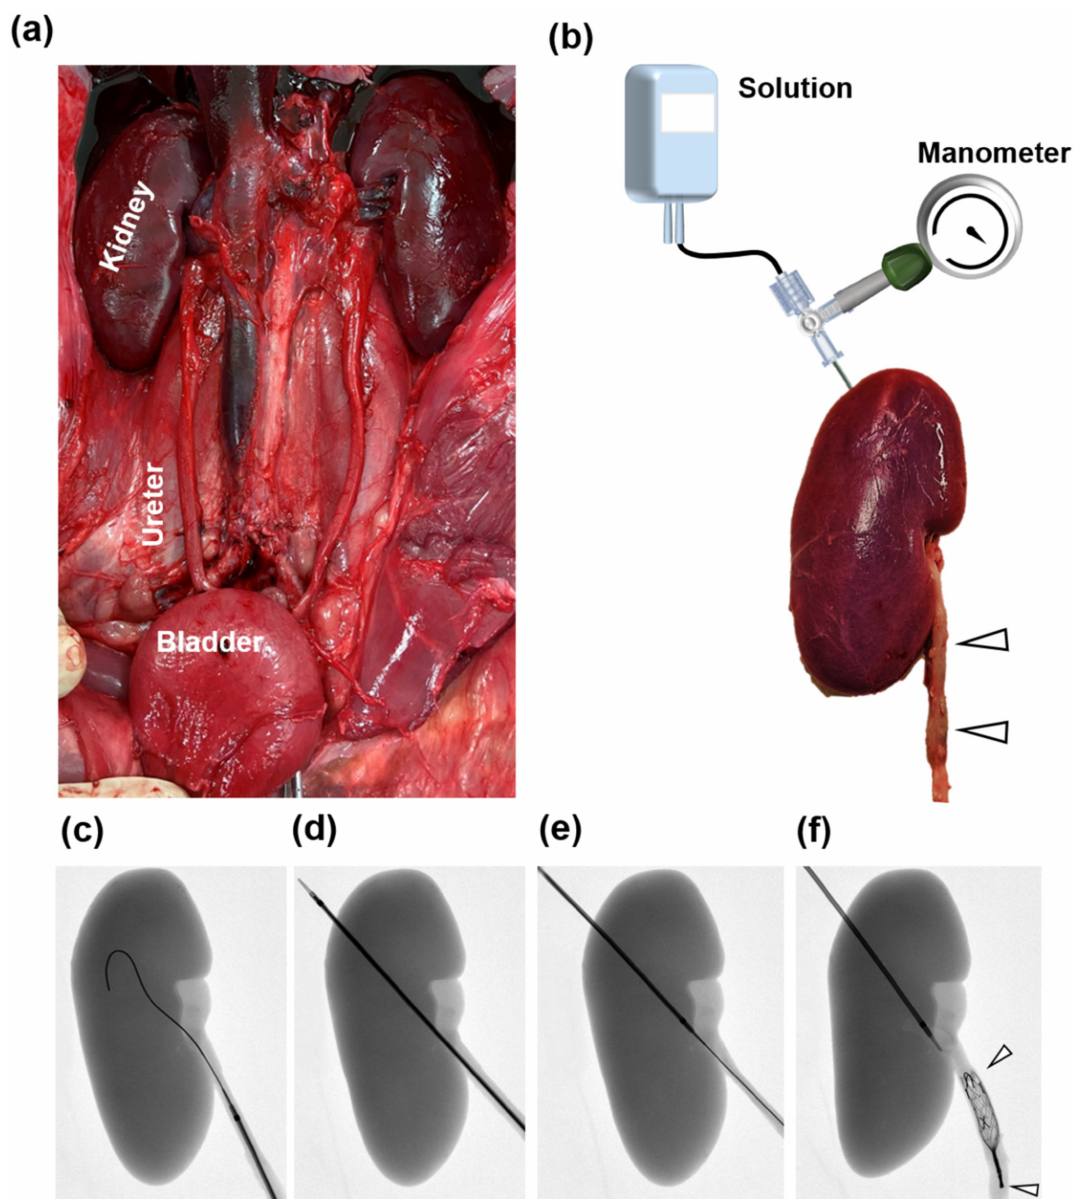
Figure 2. An image representing an ex vivo experiment. ( a ) Photograph showing the extracted porcine urinary tract, including the kidney, ureter, and bladder. ( b ) Schematic image showing the ex vivo experiment set-up with placed occlusion stent (arrowheads) in the ureter. ( c – f ) Fluoroscopic images obtained during the procedure showing technical steps of nephrostomy using the Neff percutaneous access set and placement of an occlusion stent